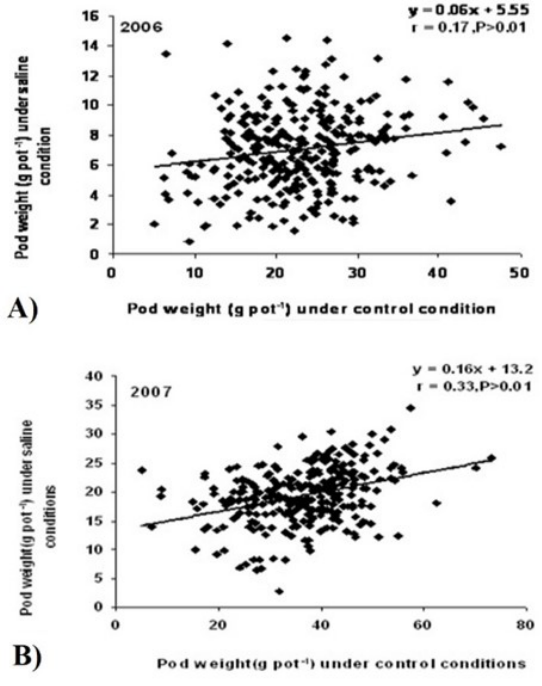
Fig. 3. The pod dry diagram. The relationship of pod dry weight under control and saline conditions in 2006 (A) and 2006-2007 (B). Data are means (n = 3) of 275